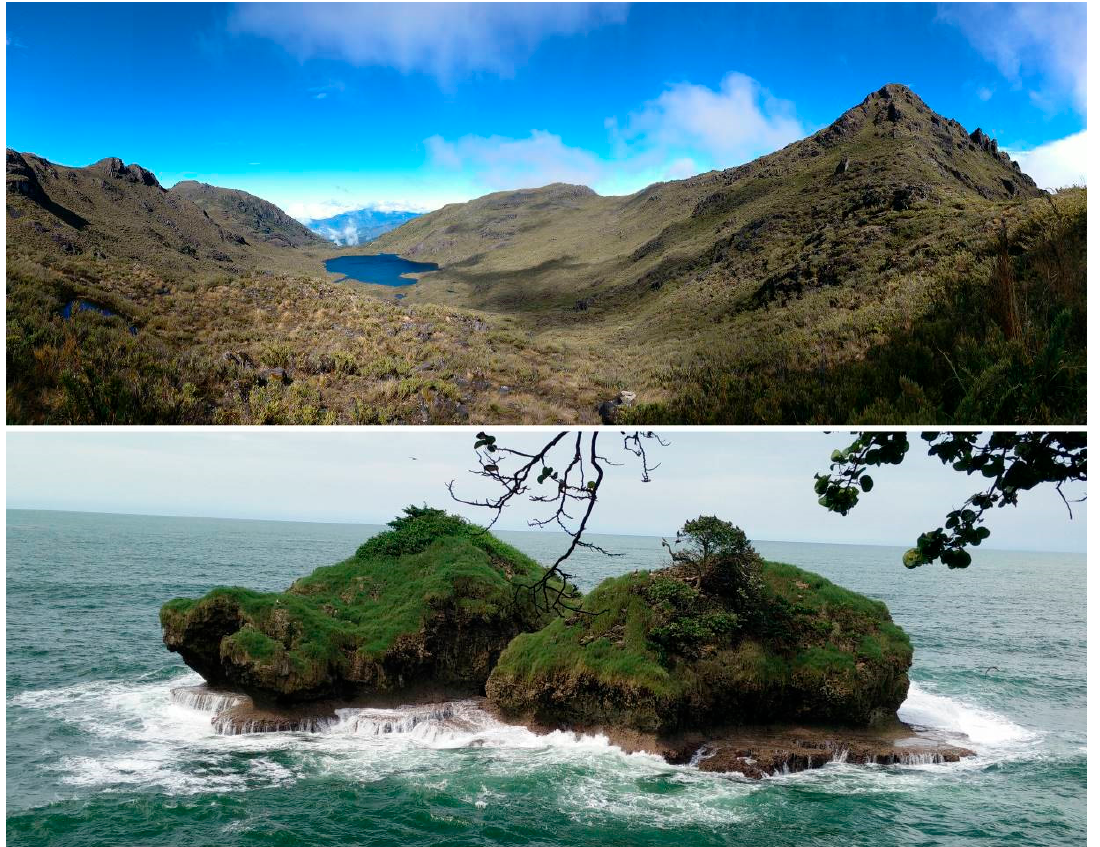
Figure 8. Glacial and karstic landforms: volcanic slopes modeled by glacial action and glacial lakes at Chirripó National Park (upper panel), and uplifted coral reef carbonate platforms in Uvita island, Limón (lower panel).